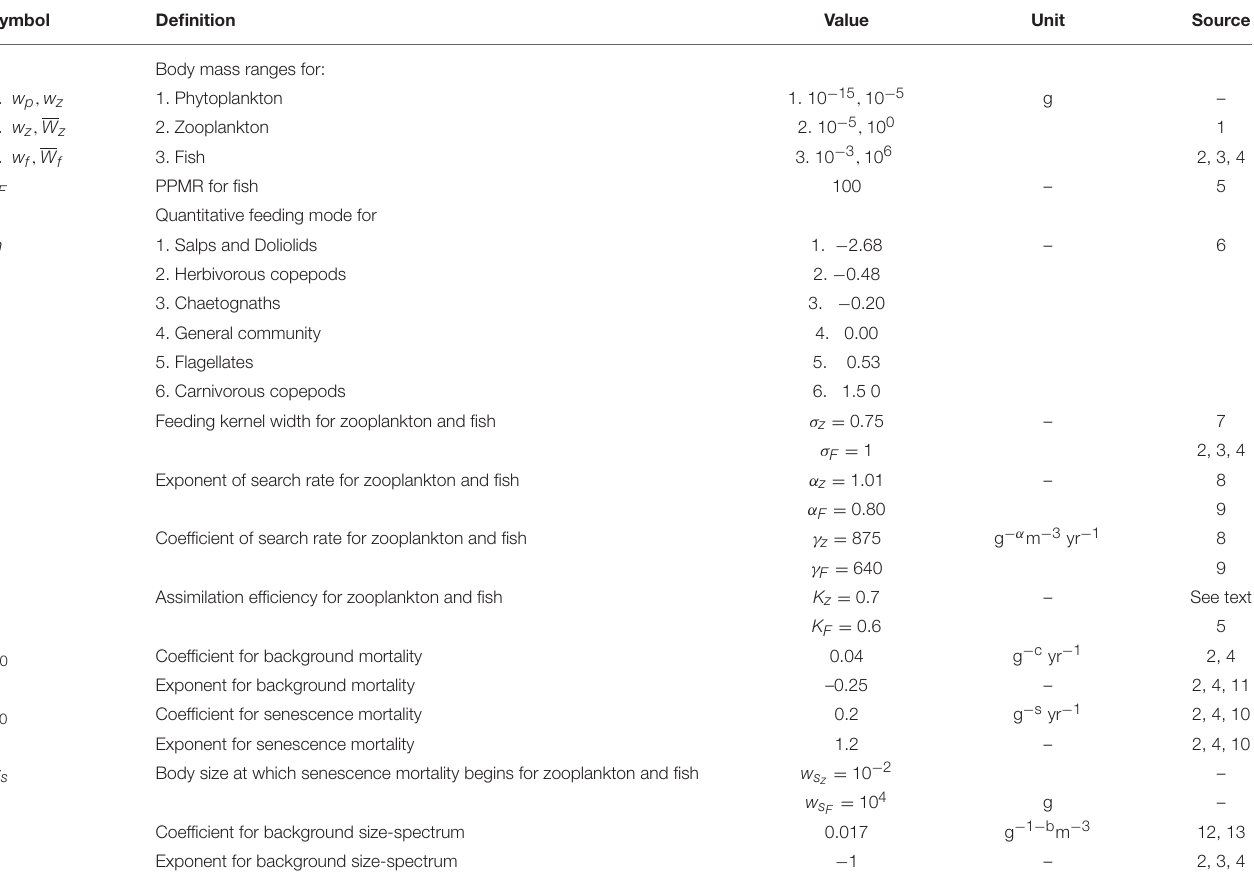
TABLE 1 | Table of parameter values for the phytoplankton–zooplankton–fish dynamic size spectrum model. Symbol Definition Value Unit Source Body mass ranges